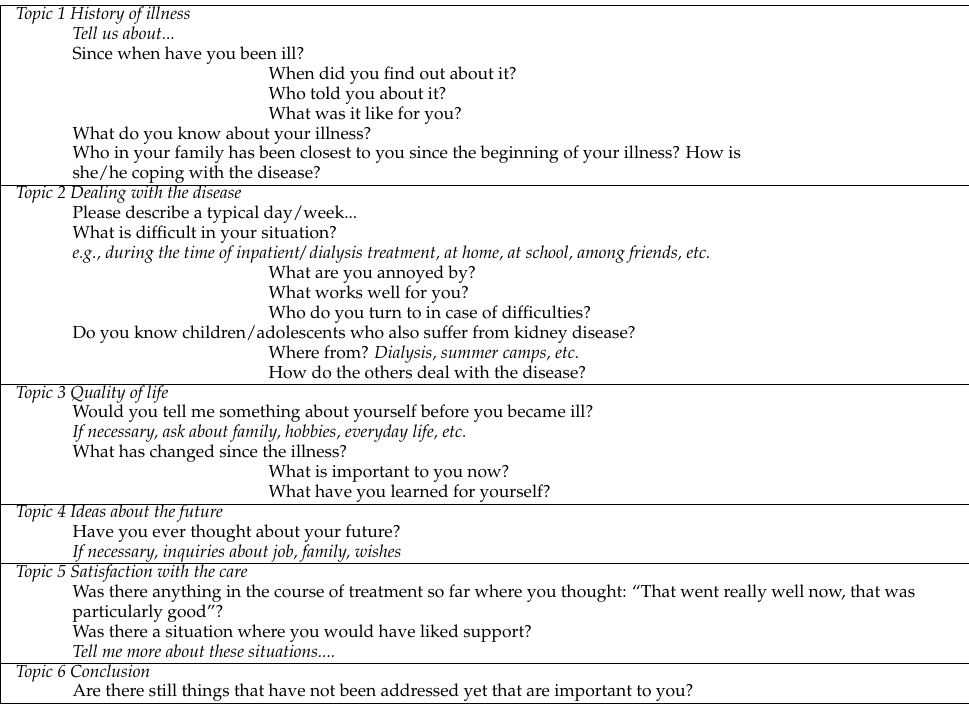
Table A2. Interview guide for adolescents and young